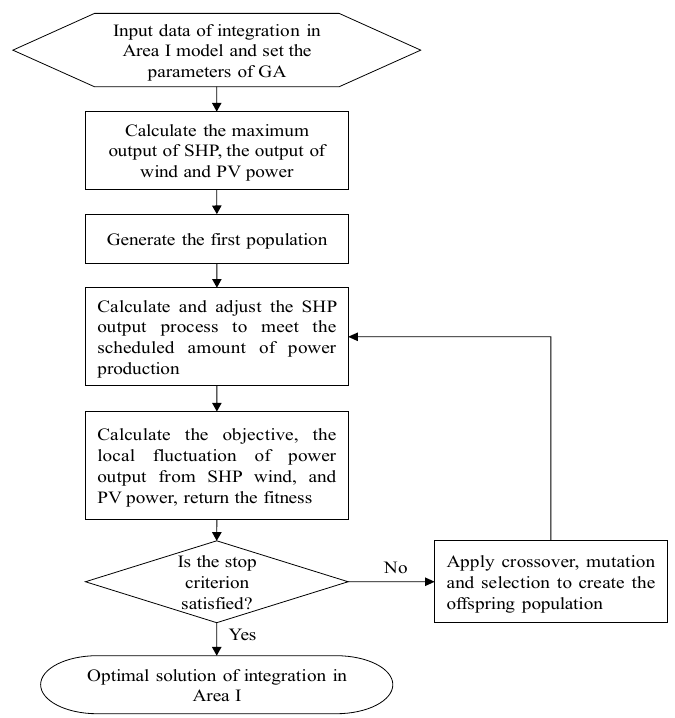
Figure 5. Flow chart of the model decomposition in Area I.